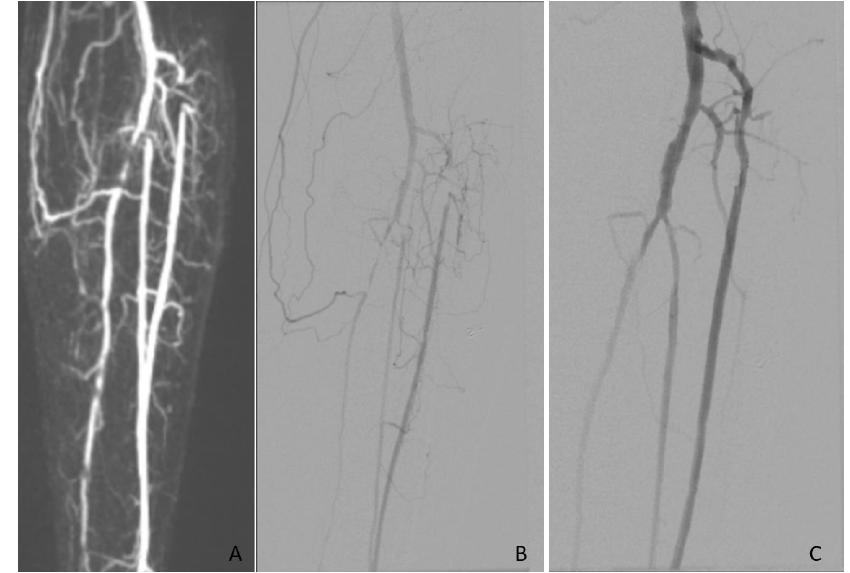
Figure 2. In this patient all three infrapopliteal vessels were affected and revascularized. Images showing short proximal occlusions in the anterior and posterior tibial artery and the fibular artery. ( A ) Magnetic resonance angiography (MRA) and ( B ) digital subtraction angiography (DSA) before and ( C ) after